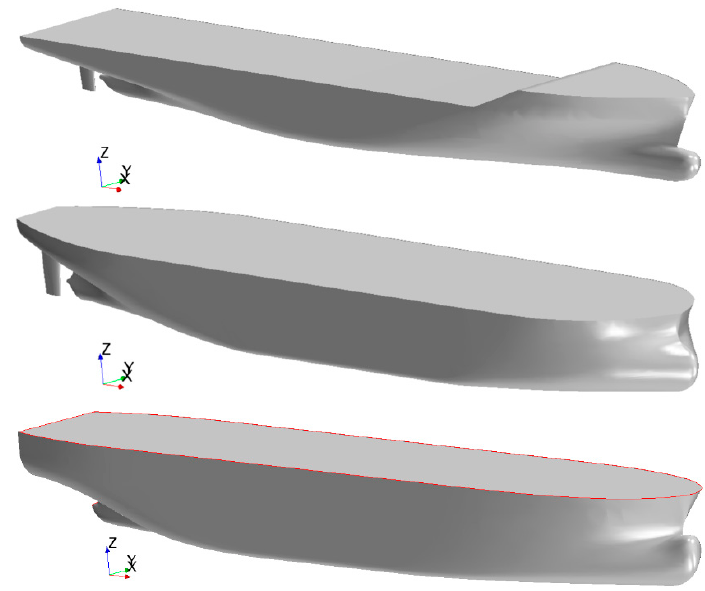
Figure 1. Geometry of the Kriso Container Ship (KCS) ( upper ), Kriso Very Large Crude-oil Carrier 2 (KVLCC2) ( middle ) and Bulk Carrier (BC) ( lower ).